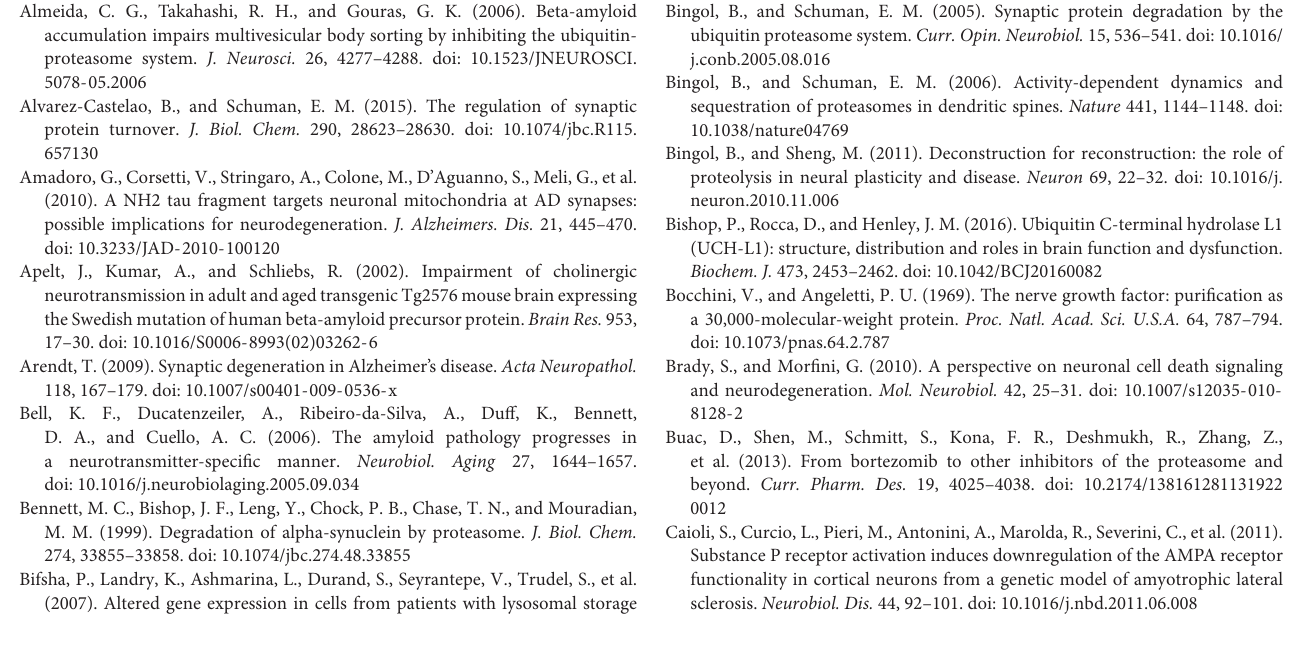
disorders suggests impairment of the ubiquitin pathway. Cell Death Differ. 14, 511–523. doi: